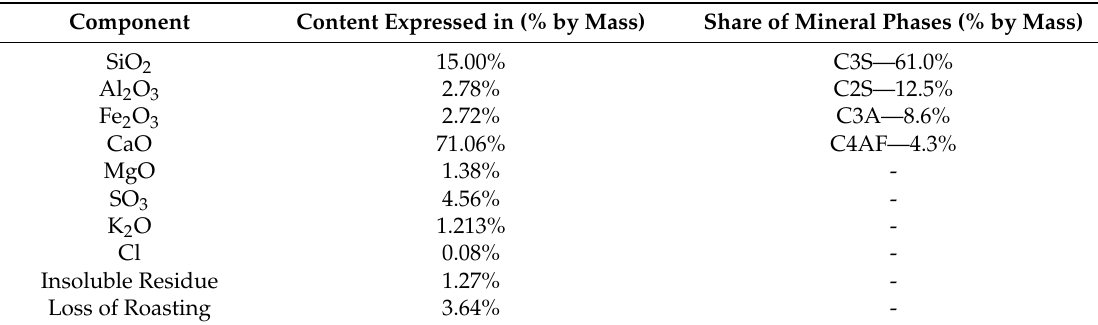
Table 2. Chemical and phase composition of the CEM I 32.5R used in the research.